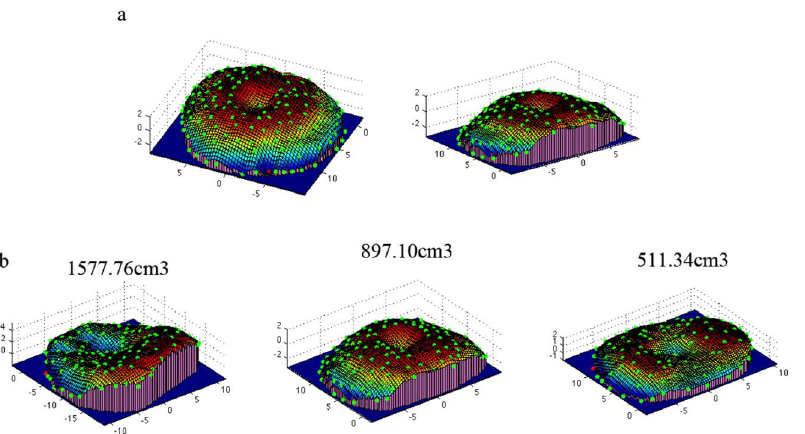
Figure 5. Reconstructions of the models. a) 3D reconstruction of the middle size artificial swelling from two perspectives. Green dots represent the original landmarks and red dot is the landmark with the lowest z-value used to compute the bottom plane (in blue). The rectangular prisms are shown in purple and the smoothed surface of the model as a colored mesh. b) 3D reconstructions of three artificial swelling models (large, middle and small) and respective volume results.